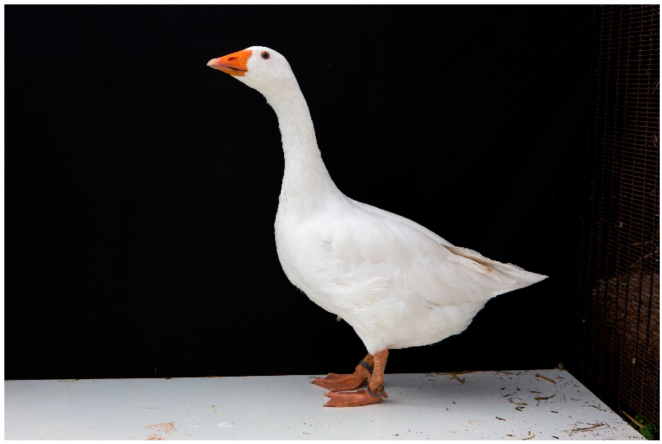
Figure 1. Goose of Vištin˙es breed. Picture made by Linas Petraška.